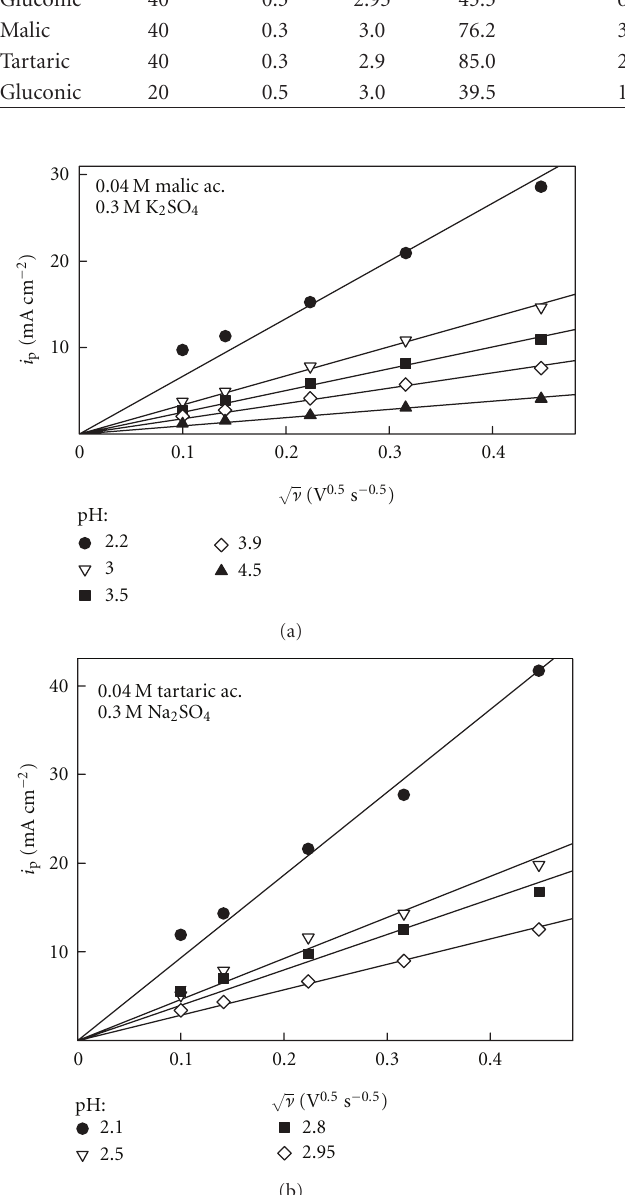
√ ν obtained at di ff erent pH